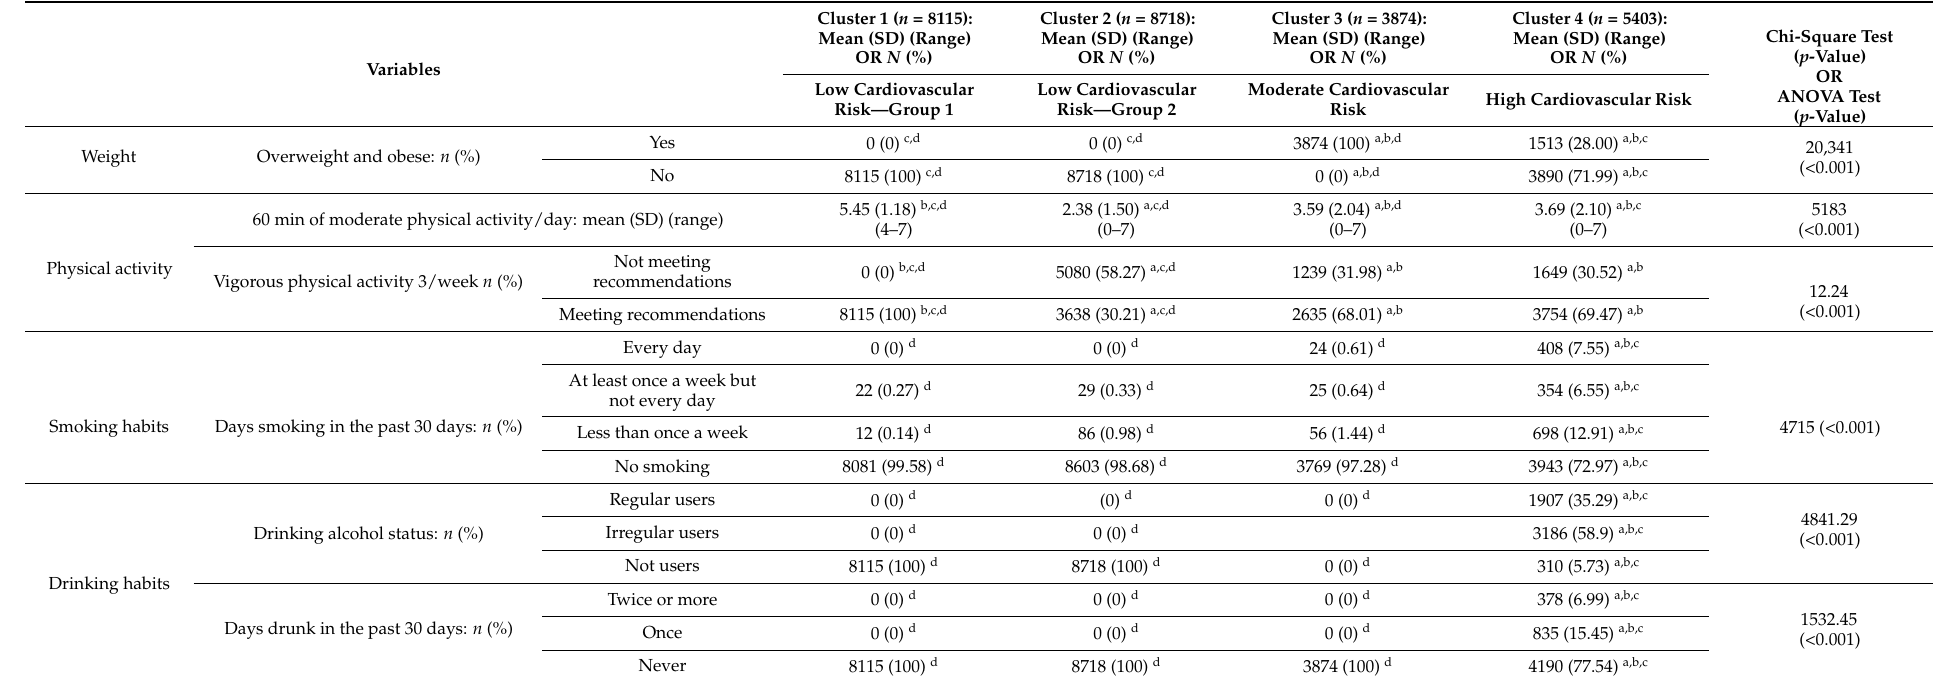
Table 3. Description of the four clusters according to lifestyle behavioral characteristics ( n =